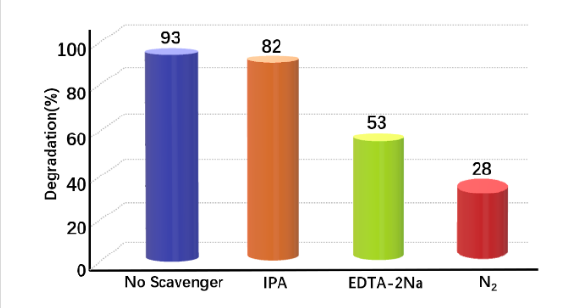
Figure 8: Trapping of reactive species during the photodegradation of TC over 2.5 wt % Au/CBO composite under visible-light irradiation.